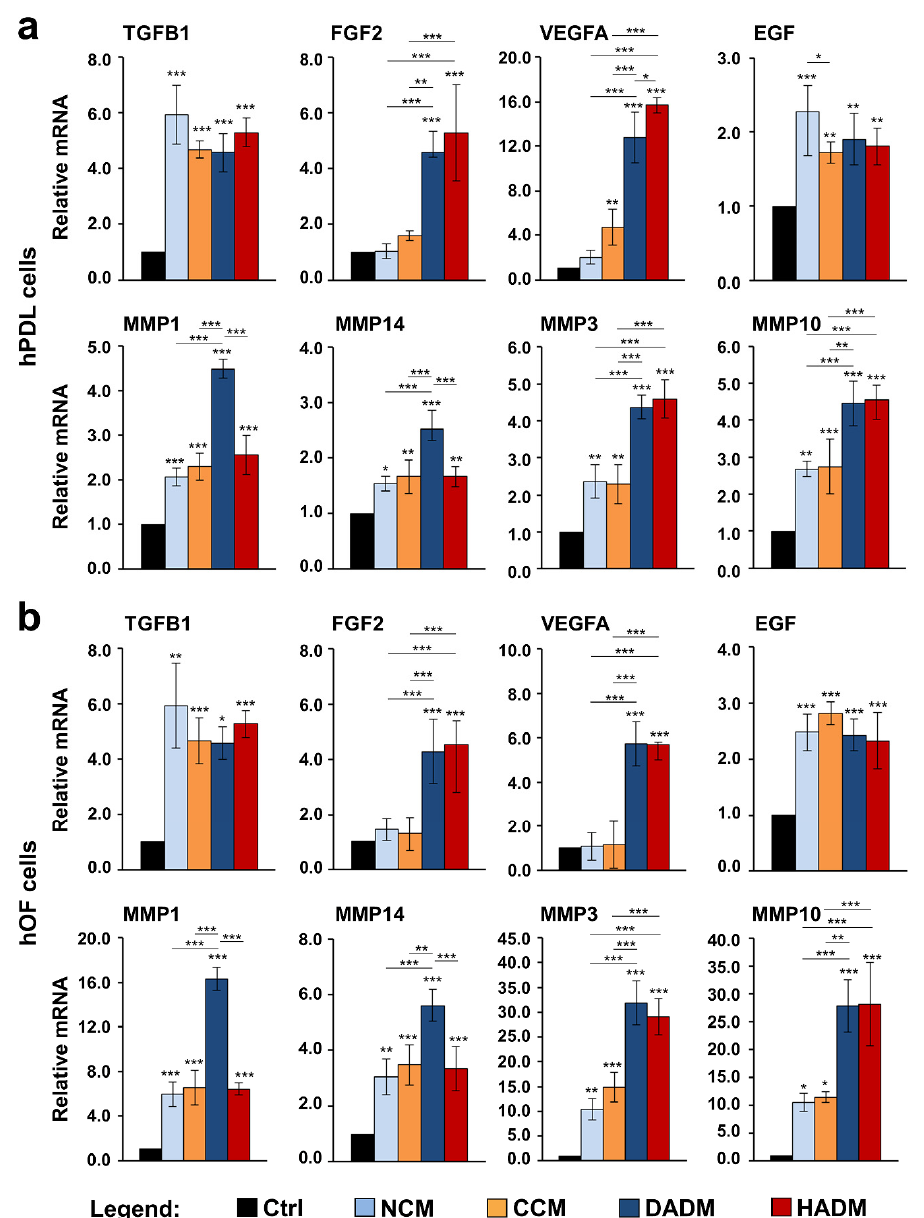
Figure 6. Increased expression of wound healing-related genes in two oral cell types grown on four di ff erent collagen matrices. hPDL ( a ) and hOF ( b ) cells were cultured on four di ff erent collagen matrices (NCM, CCM, DADM, and HADM) for 24 h before total RNA was isolated and analyzed for the expression of TGFB1, FGF2, VEGFA, EGF, MMP1, MMP14, MMP3, and MMP10 by qRT-PCR. Controls (Ctrl) represent cells of each cell type grown on cell culture plastic in the absence of a collagen matrix. Values normalized to GAPDH are expressed relative to the values of control cells. Data represent means ± SD from three independent experiments performed with three di ff erent cell donors for each of the two cell types. Significant di ff erences to the respective controls unless otherwise indicated, *** p < 0.001, ** p < 0.01, * p <